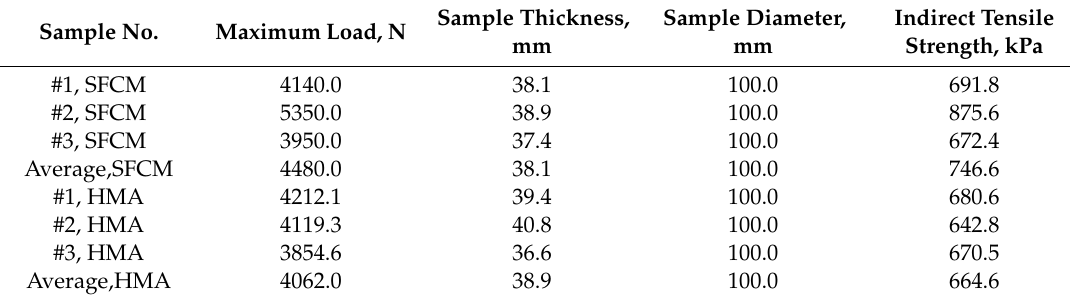
Table 4. High temperature indirect tensile strength testing results (42 ◦